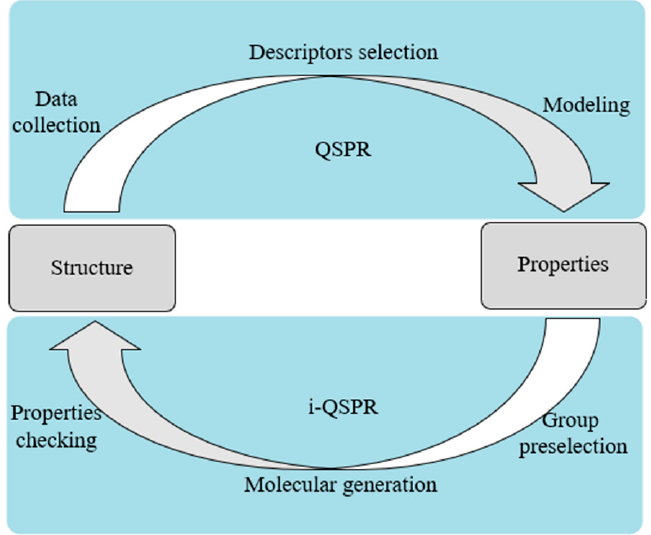
Figure 1. Relationship between QSPR and i-QSPR. QSPR can build a bridge from the molecular structure to thermophysical properties, which enables the design of the working fluids of ORC. However, studies that combine the working fluids of ORC with QSPR are rarely reported, and further research is required in this